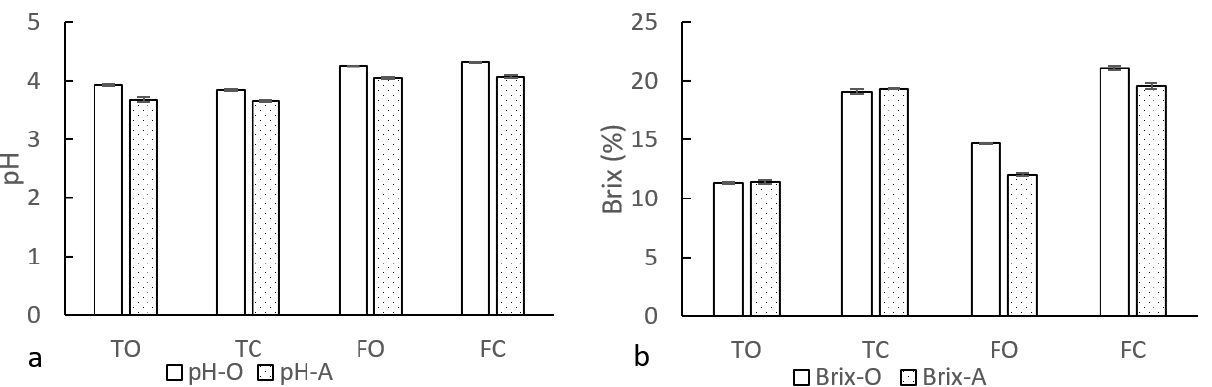
Figure 1. The pH ( a ) and TSS ( b ) of juice. TO, TC, FO and FC are Tropicana original juice, Tropicana concentrated juice, freshly squeezed original juice and freshly squeezed concentrated juice respec- tively. O and A are the abbreviations for orange and apple. Each treatment was repeated three times and data were expressed by mean ± standard